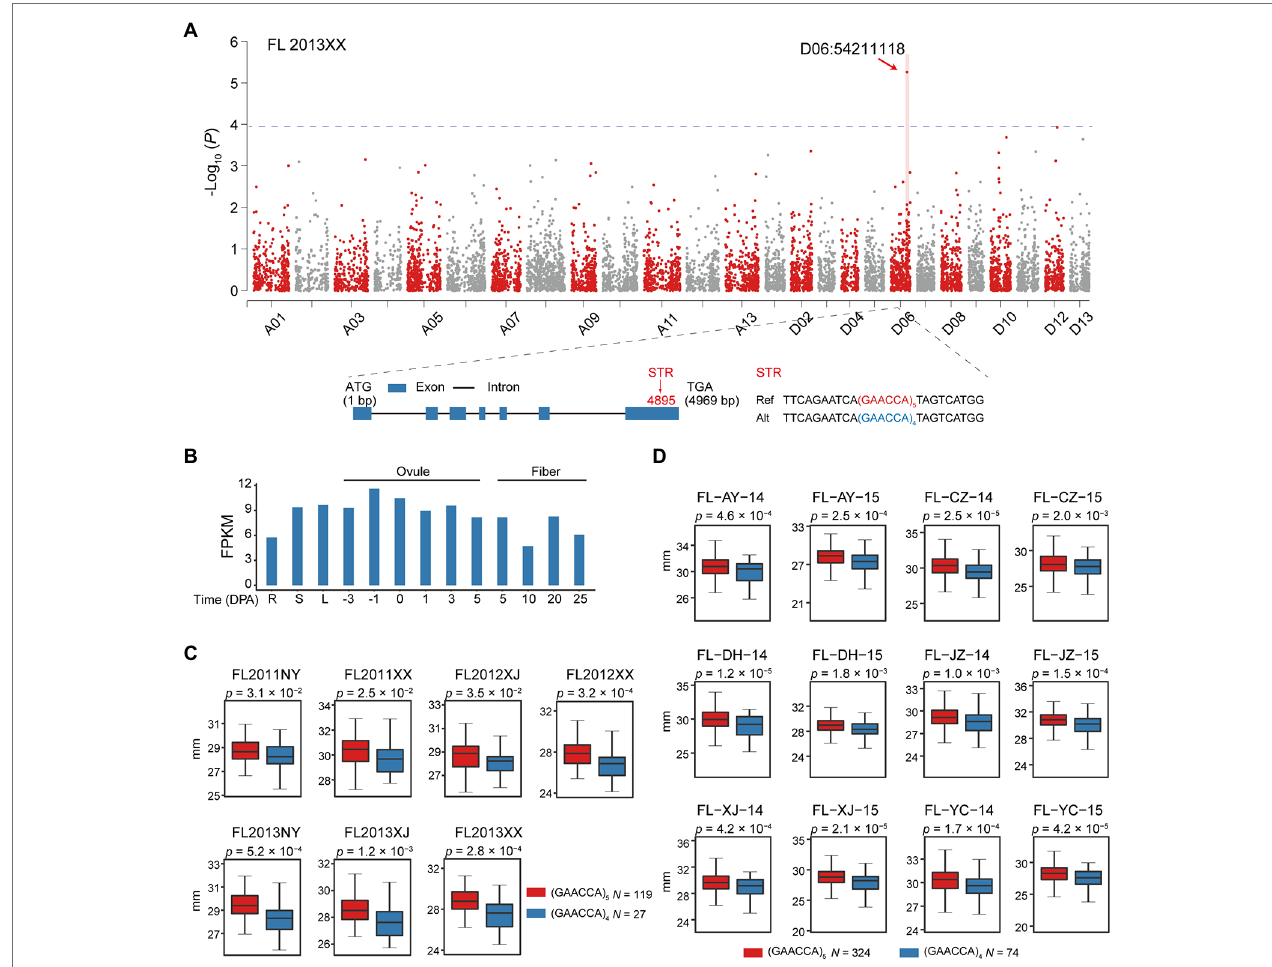
FIGURE 5 | Identification of a candidate gene, GH_D06G1697 , harboring a polymorphic STR (D06:54211118) associated with fiber length. (A) Manhattan plot for fiber length. Statistical analysis was performed with the two-sided t -test in P2. Exon-intron structure of GH_D06G1697 and the exonic STR D06:54211118. Blue rectangles and black lines, respectively, indicate exons and introns. Ref, reference; Alt, alternate. (B) Expression level of GH_D06G1697 during ovule and fiber development stages in different tissues, including root (R), stem (S), and leaf (L), with values as FPKM. (C) Box plot of fiber length in relation to genotype of the exonic STR D06:54211118 ( n = 119 vs. 27) in P2. Center line, median; box limits, upper and lower quartiles; and whiskers, 1.5× the interquartile range (two-sided t -test). NY: Nanyang in Henan province; XX: Xinxiang in Henan province; and XJ: Korla in Xinjiang. (D) Box plot of fiber length in relation to STR genotype ( n = 324 vs. 74) in P3. Center line, median; box limits, upper and lower quartiles; and whiskers, 1.5× the interquartile range (two-sided t -test). AY: Anyang in Henan Province; CZ: Cangzhou in Hebei Province; DH: Dunhuang in Gansu Province; JZ: Jingzhou in Hubei Province; XJ: Alaer in the Xinjiang; and YC: Yancheng in Jiangsu